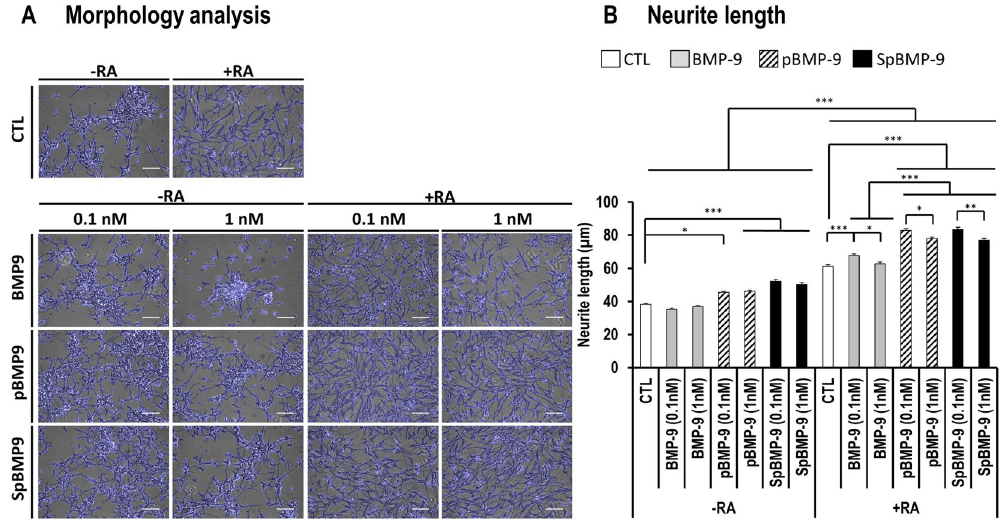
Figure 3. Effect of pBMP-9 and SpBMP-9 on the morphology of SH-SY5Y cells and neurite length. ( A ) Modified phase-contrast pictures of SH-SY5Y cells stimulated for 5d with equimolar concentrations (0, 0.1 and 1 nM) of BMP-9, pBMP-9 and SpBMP-9 + / − 10 μ M RA. Pictures are representative of at least 3 independent experiments performed in duplicate. Neurites and cell bodies were highlighted with an edge-detection filter and superimposed (blue edges) on the original phase contrast image (Bar = 100 μ m). ( B ) Average neurite length of SH-SY5Y cells stimulated for 5d with equimolar concentration of BMP-9, pBMP-9 or SpBMP-9 (0.1 and 1 nM) + / − 10 μ M RA determined as the Euclidean distance between the end of neurites and the cell body. Results are the means ± SEM of at least 3 independent experiments performed in duplicate, where a total of over 300 measurements were taken per experimental condition ( * p < 0.05, ** p < 0.01, *** p <